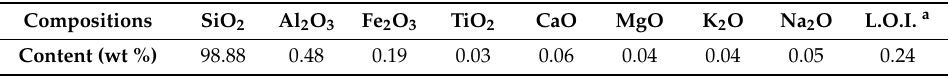
Table 1. Chemical analysis of the dry NPQ (wt